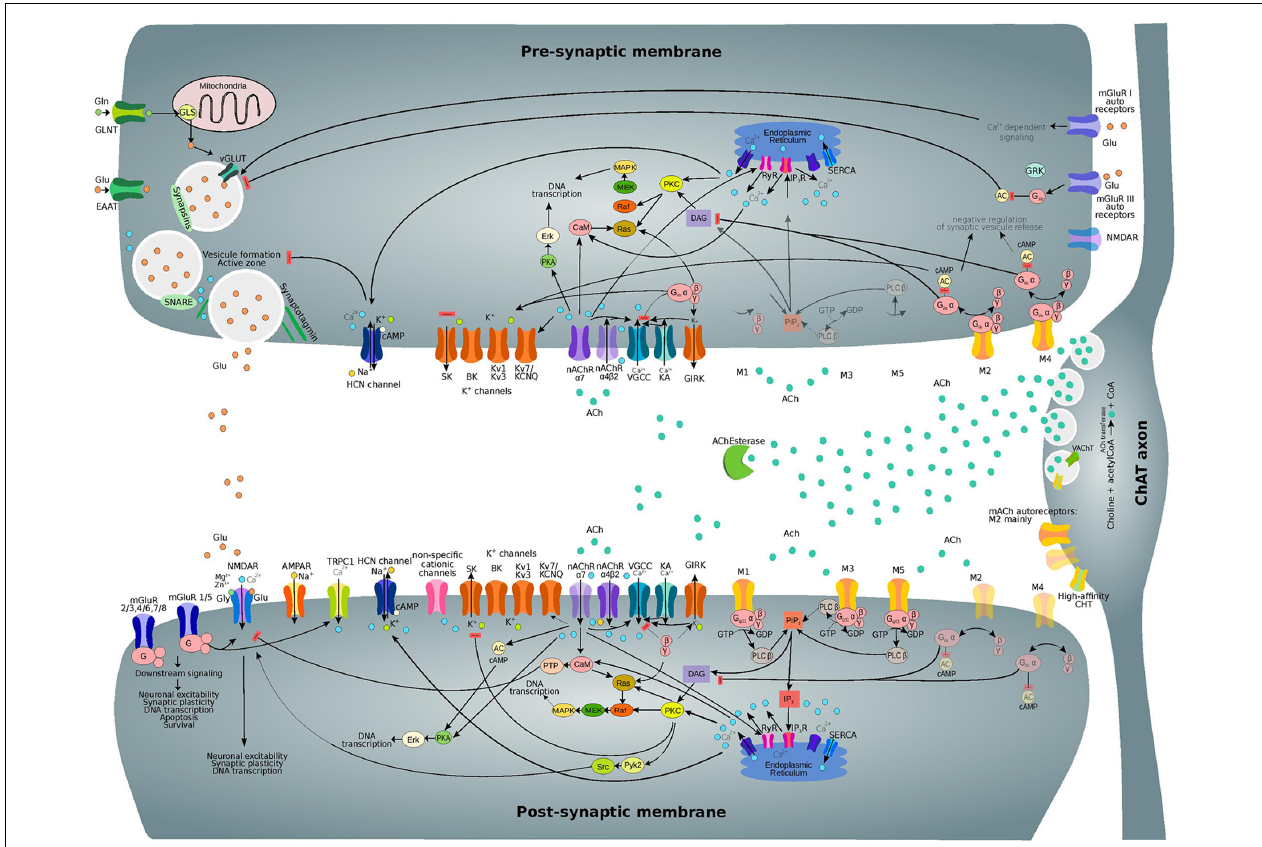
FIGURE 4 | Subcellular nicotinic and muscarinic signaling processes at the glutamatergic synapse being modulated by ACh. Only the main relevant pathways and components are shown. Receptor subtypes which are less expressed on pre and post-synaptic membranes and related downstream processes are shown in semi-transparent colors. Abbreviations: ACh, acetylcholine; ACh Esterase, acetylcholinesterase; M1-M5, muscarinic acetylcholine receptor types 1–5; nAChR ( α 7, α 4 β 2), nicotinic acetylcholine receptor (types α 7, α 4 β 2); VGCC, voltage-gated calcium channel; KA, kainate receptor; GIRK, G-protein activated inward rectifier K + channel; PKA, protein kinase A; CaM, calmodulin; AC, adenylyl cyclase; DAG, diacylglycerol; PKC, protein kinase C; NOS, NO-synthase; HO-2, heme oxygenase 2; sGC, soluble guanylyl cyclase; PKG, cGMP-dependent protein kinase; HCN, hyperpolarization-activated cyclic nucleotide-gated channel; TRPC1, transient receptor potential cation channel 1; mGluR, metabotropic glutamate receptor; Pyk2, protein-tyrosine kinase 2; PiP2, phosphoinositol-1,4,5-biphosphate; PLC β , phospholipase C β ; IP 3 , inositol triphosphate; IP 3 R, IP 3 receptor; RyR, ryanodine receptor; SERCA, sarco-endoplasmic reticulum Ca 2 +